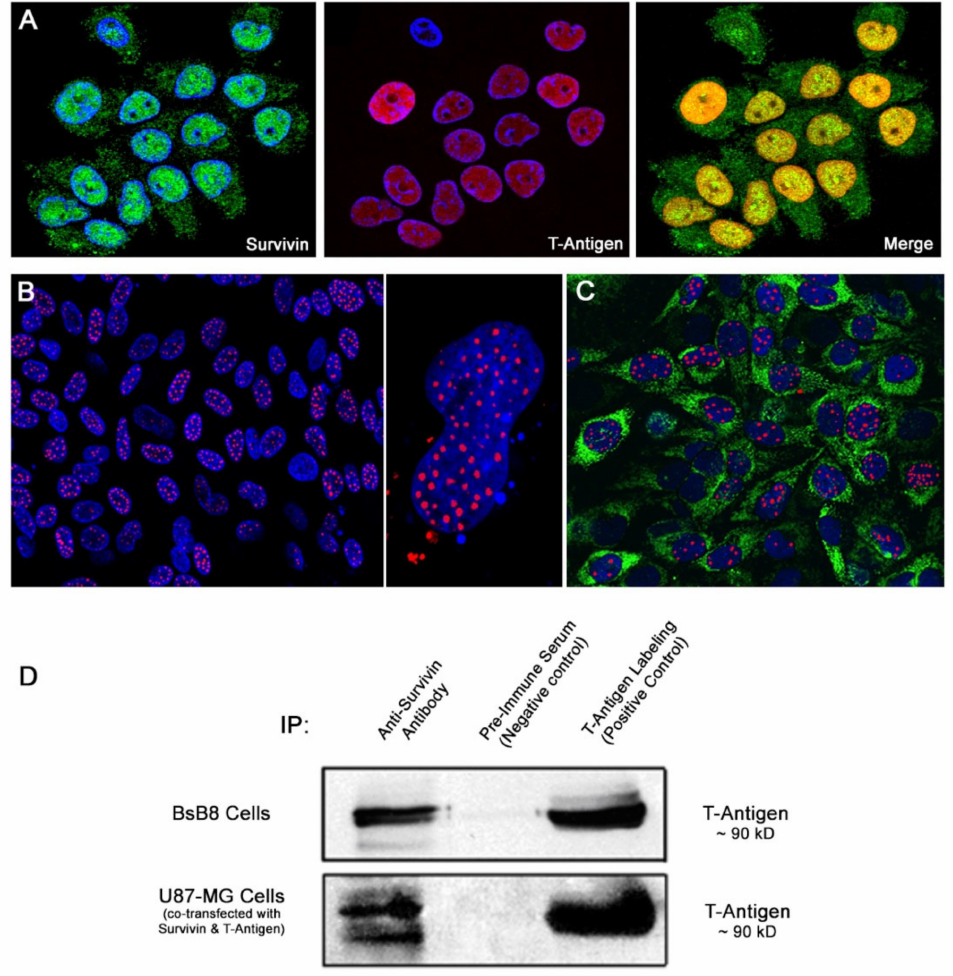
Figure 3. Physical interaction between JCPyV T-Antigen and Survivin in in vitro experiments. ( A ) Double-labeling immunocytochemistry of JCPyV-infected primary astrocytes demonstrates the co-localization of the anti-apoptotic protein Survivin (green) and large T-Antigen (red) in the nuclei of infected cells (All panels original magnification is 200 × ). ( B ) Proximity Ligation Assay (DuoLink) demonstrates the physical interaction between these two proteins in the nuclei of JCPyV-infected cells (left panel original magnification is 100 × , right panel 1200 × ). ( C ) Furthermore, and